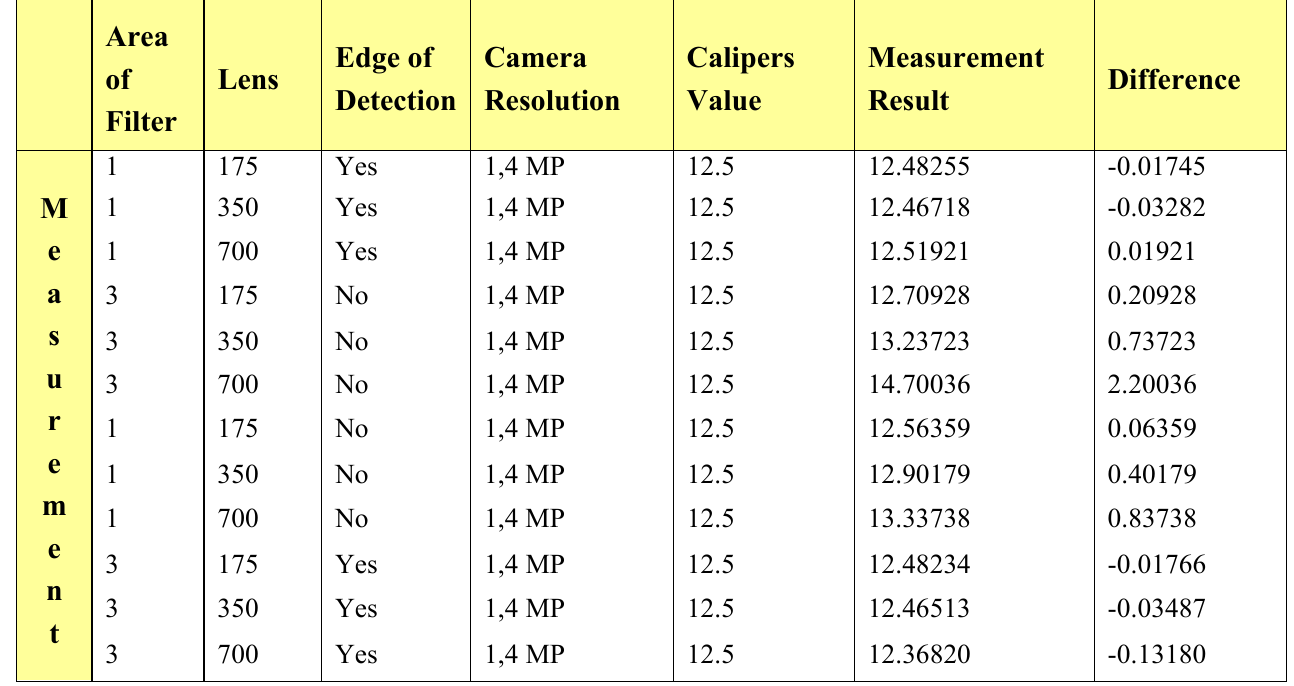
Table 3. Evaluation of hole diameters with different lenses and parameters.